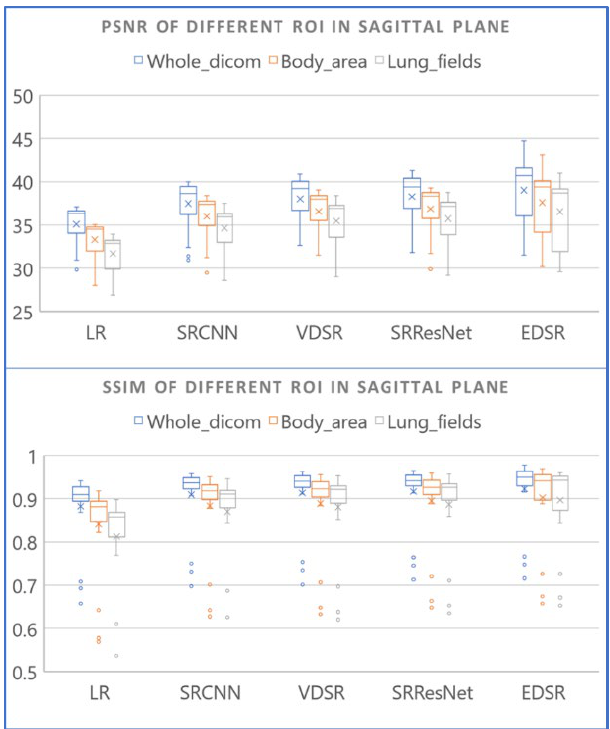
Figure 12. PSNR and SSIM values of ROIs for different AI models. All results represent applying the AI models to sagittal planes.